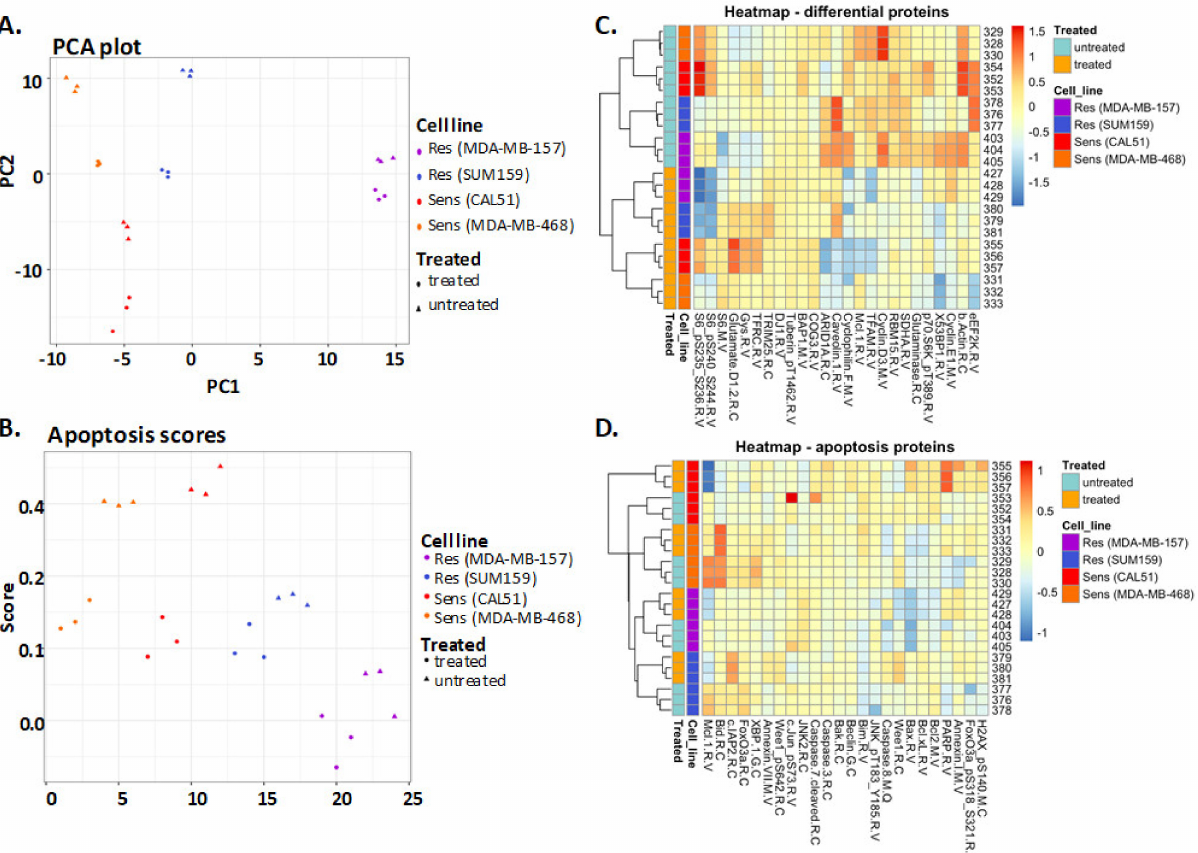
Figure 2. Gene set-exclusive analysis using apoptotic score (AS) gene sets in association with ONC201-sensitive versus -resistant TNBC cell lines using RPPA data. ( A ) PCA results showing that the degree of overall 24 apoptosis-related protein expression changes before and after ONC201-based treatment was much greater in ONC201-sensitive (Sens) cell lines but smaller in ONC201-resistant (Res) cell lines. PC1, averaged protein level of each cell line; PC2, average protein level of each treatment condition. ( B ) Results of PCA according to AS in four TNBC cell lines showing differences in AS score induced by ONC201-based treatment in the cell lines that were ONC201-sensitive and -resistant. The differences were not significant. ( C , D ) Heat maps of the ( C ) differential and ( D ) apoptosis protein levels in each cell line according to an RPPA assay, which do not show proteins significantly correlated with ONC201